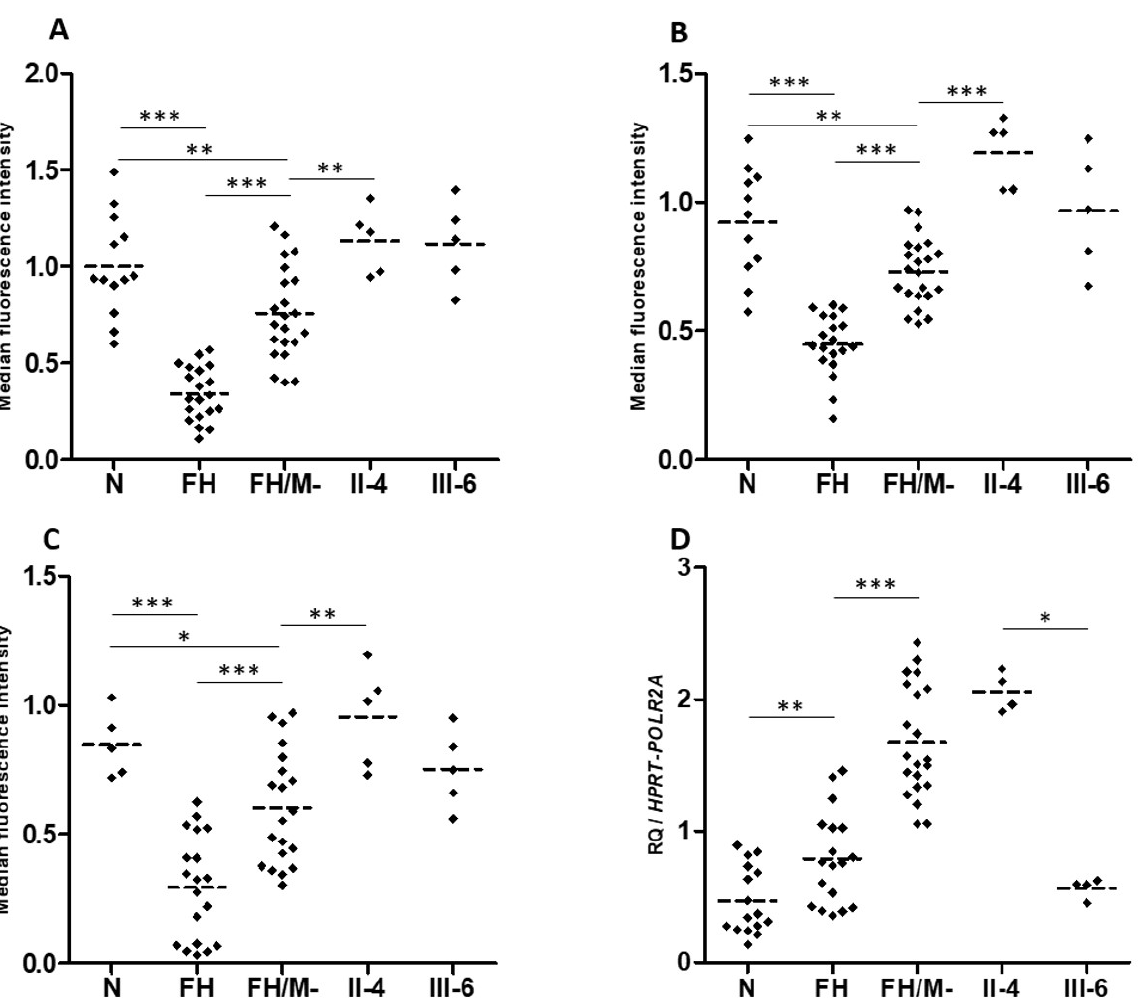
Figure 5. LDL receptor expression, LDL binding and uptake, and LRP6 gene expression in pa- tients EBV-transformed B-lymphocytes. ( A ) LDL receptor, ( B ) LDL-Bodipy binding and ( C ) LDL- Bodipy uptake quantification in EBV-transformed B-lymphocytes from normocholesterolemic subjects (N), LDLR mutation carriers (FH), hypercholesterolemic patients without an identified mutation (FH/M-), and two LRP6 -p.(Val1382Phe) carriers from the HC438 family: II-4 and III-6 (see Figure 1). The median fluorescence of living cells is presented. Data represent five independently performed assays. ( D ) LRP6 gene expression. Relative Quantification (RQ) of LRP6 in EBV-transformed B- lymphocytes. Reactions were run in triplicate for each cDNA. HPRT and POL2RA were used as reference genes. The relative quantification was performed using the ∆ C T method. ( A – D ). Bonfer- roni’s Multiple Comparison Test in one-way ANOVA: * p < 0.05, ** p < 0.01, *** p <